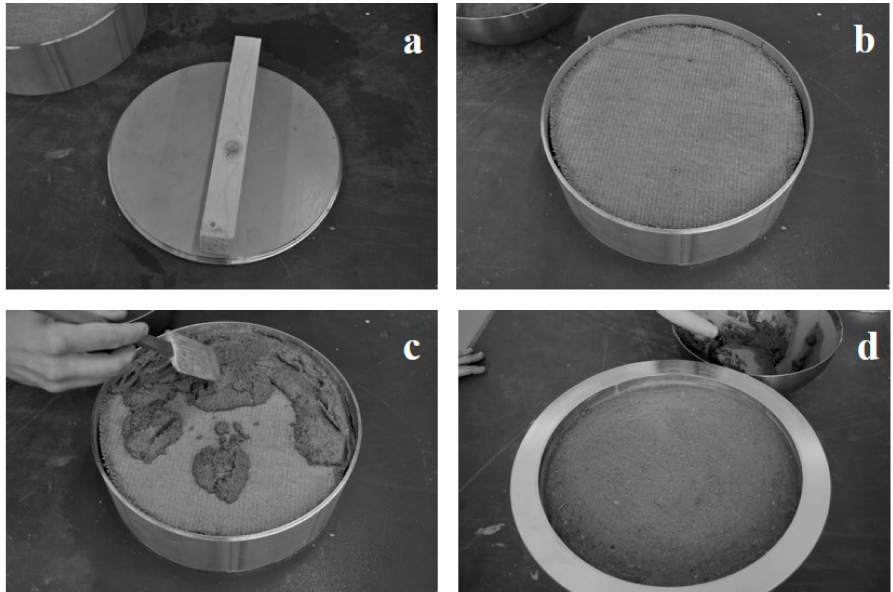
Figure 1. Sample installation into sample intake: ( a ) timber stud, ( b ) mounted earth dry board (wood fibre insulation below), ( c ) earth plaster final coat, ( d ) mounting of flanged section ring for installation into test chamber.